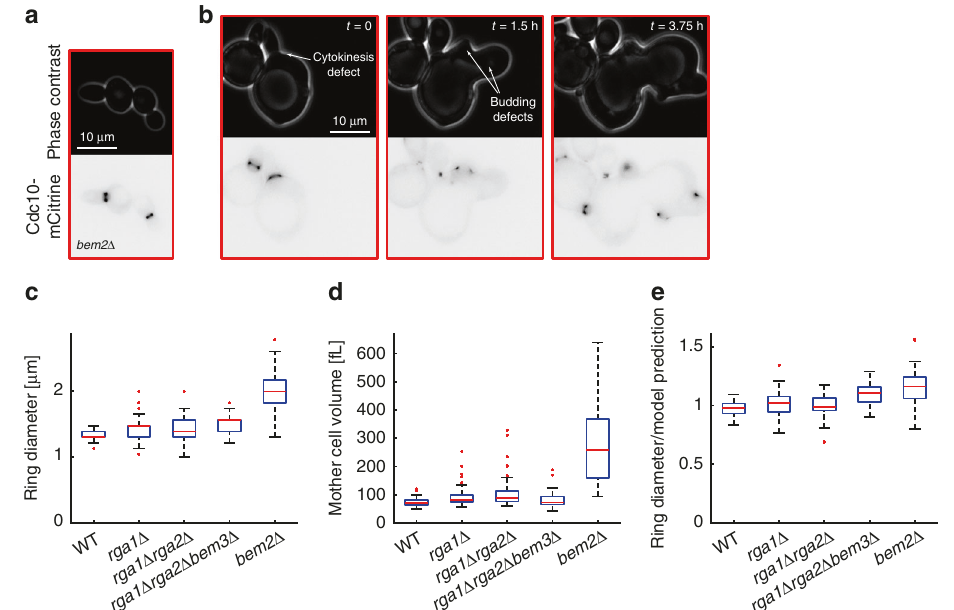
Fig. 6 Increased ring diameter in bem2 Δ cells is largely explained by increased cell volume. Cell volume and septin ring diameter based on Cdc10- mCitrine fl uorescence were measured in haploid GAP deletion mutants rga1 Δ (43 cells pooled from two independent experiments), rga1 Δ rga2 Δ (50 cells pooled from two independent experiments), rga1 Δ rga2 Δ bem3 Δ (42 cells pooled from two independent experiments), and bem2 Δ (42 cells pooled from two independent experiments) and compared with wild-type haploids (52 cells pooled from two independent experiments). Cells with obvious defects in bud formation, cytokinesis, and septin morphology were rejected from the analysis. Live-cell microscopy images of bem2 Δ cells (phase contrast (top) and mCitrine fl uorescence (bottom)) show typical examples of normal ring morphology included in the analysis ( a ), and a timecourse of a typical cell rejected from the analysis due to cytokinesis and budding defects ( b ). c Boxplots showing the distribution of septin ring diameters. For each cell, the median ring diameter during the time when the ring is detected is measured. d Boxplots of the median cell volume during that time. e For each cell, we compare the measured ring diameter to the value expected for wild-type cells with the same mother cell volume based on the power law fi t obtained for wild-type and inducible-Whi5 cells grown on SCD shown in Fig. 3a. Boxplots depict the distribution of the ratios of measured and expected ring diameters. Cells were grown on SCD. Boxplots depict medians, and 25 and 75 percentiles. Whiskers denote extreme values still within 1.5 interquartile ranges, red symbols denote outliers. Source data are provided as a Source Data fi